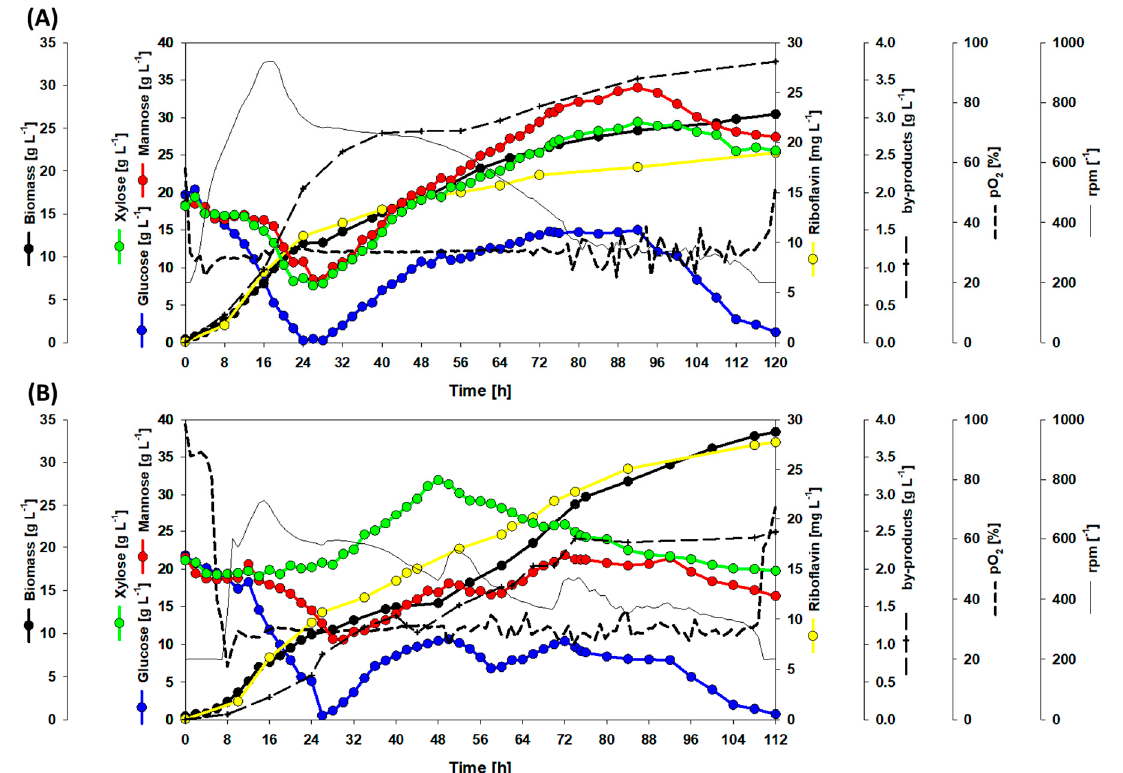
Figure 7. Growth and production during fed-batch fermentation of the strain RiboSSL ( A ) and the dynamic co-cultivation of RiboMan and RiboXyl ( B ). Data is depicted as follows: glucose consumption (blue line), mannose consumption (red line), xylose consumption (green line), riboflavin accumulation (yellow line), biomass formation (thick black line), stirring profile (thin black line), pO 2 profile (dotted line), and the sum of by-products (dashed line) (by-products details in Figure 8). The feeding started after glucose depletion and lasted 65 h with a linear rate of 0.4 mL min − 1 . One replication of each cultivation was carried